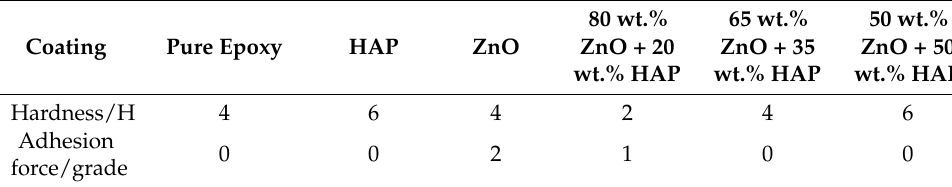
Table 4. Results of mechanical performance of coatings with different components.